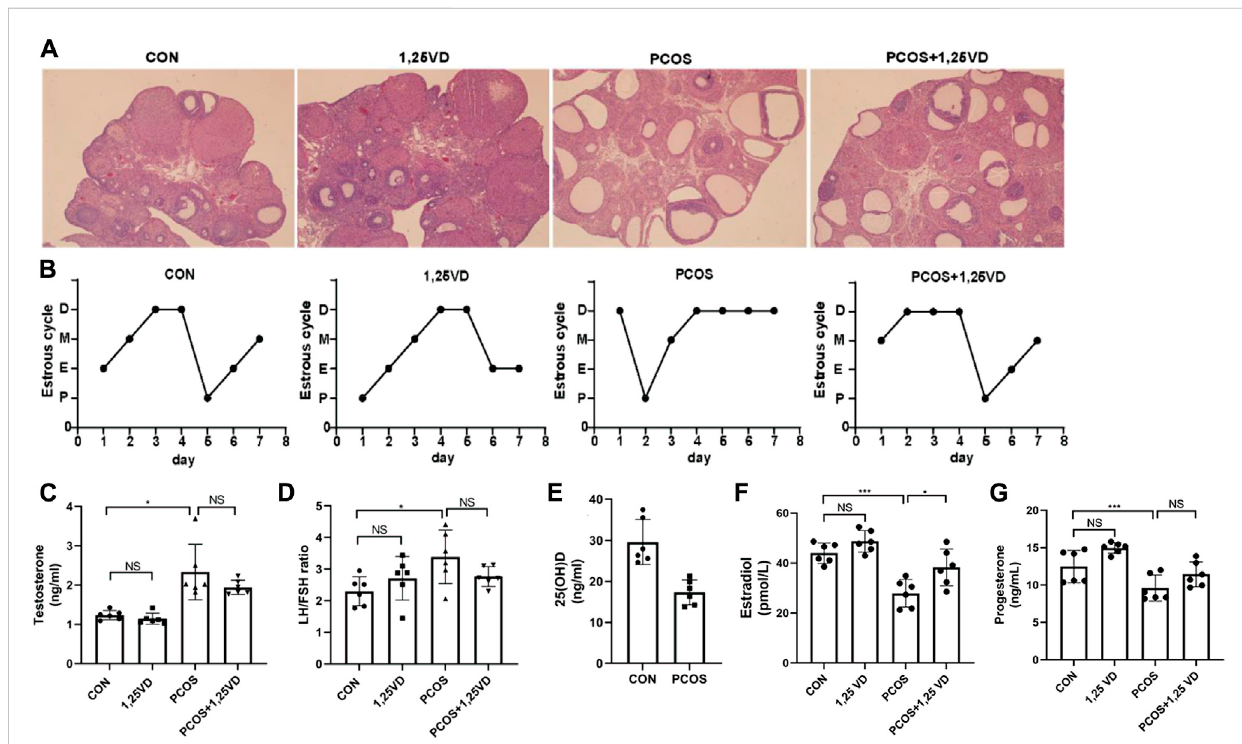
FIGURE 2 Ovarian morphology (A) , estrus cycle (B) , serum testosterone levels (C) , LH/FSH ratio (D) , 25(OH)D (E) , estradiol (F) and progesterone (G) of the different groups. D: Diestrus, M: Metaoestrus, E: Estrus, P: Proestrus, LH: Luteinizing hormone, FSH: Follicle stimulating hormone. * p < 0.05, ** p < 0.01, *** p <